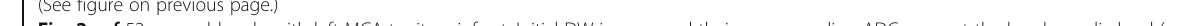
Table 2 Patients ’ demographic data and imaging findings